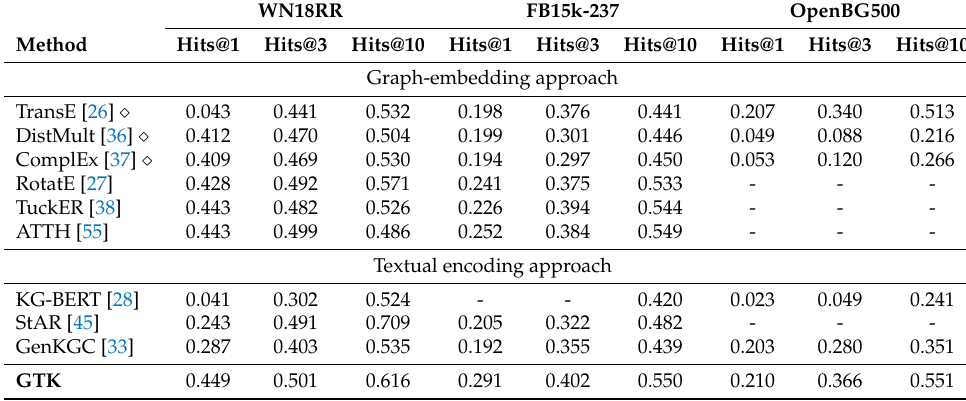
Table 3. Evaluation results on WN18RR, FB15k-237, and OpenBG500. Note that the (cid:5) resulting numbers were reported by previous works, which means that we reproduced the experimental results on OpenBG500 and took other results from the original papers.